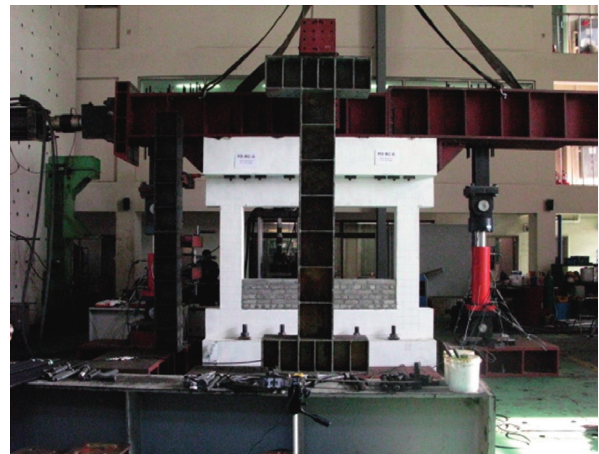
Figure 9: Test configuration.